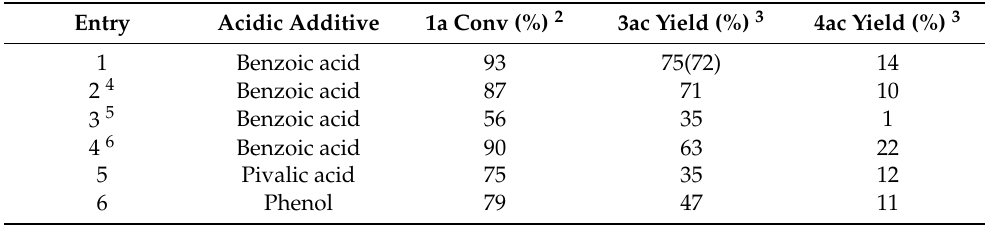
Table 3. Synthesis of 5-arylimidazole 3c by direct arylation of 1-methylimidazole ( 1a ) with 1-bromo- 4-nitrobenzene ( 2c ) in SA anisole using benzoic acid as additive.